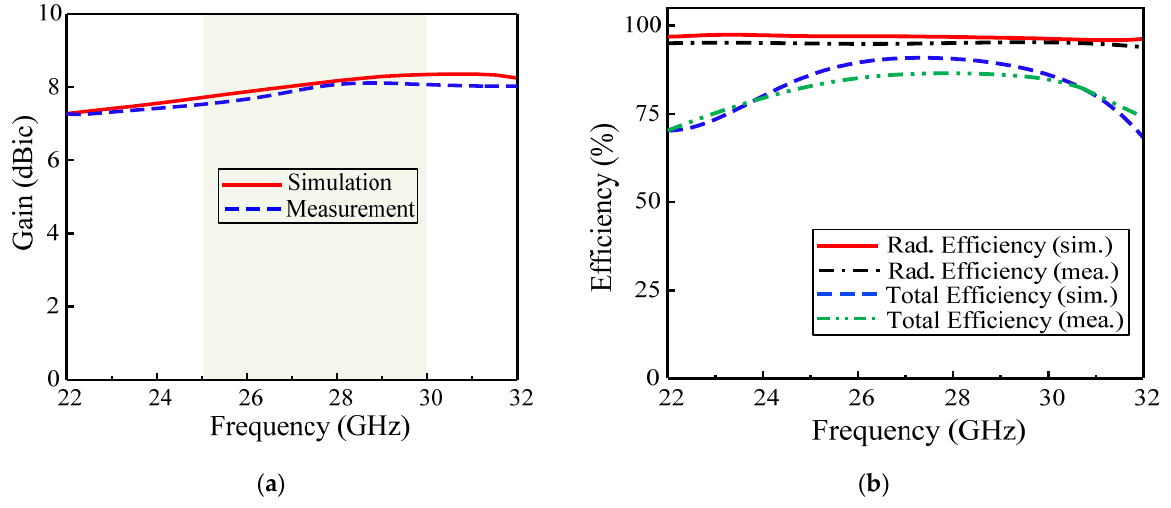
Figure 6. Proposed CP ME dipole antennas: ( a ) broadside gain, ( b ) radiation efficiency and total efficiency.